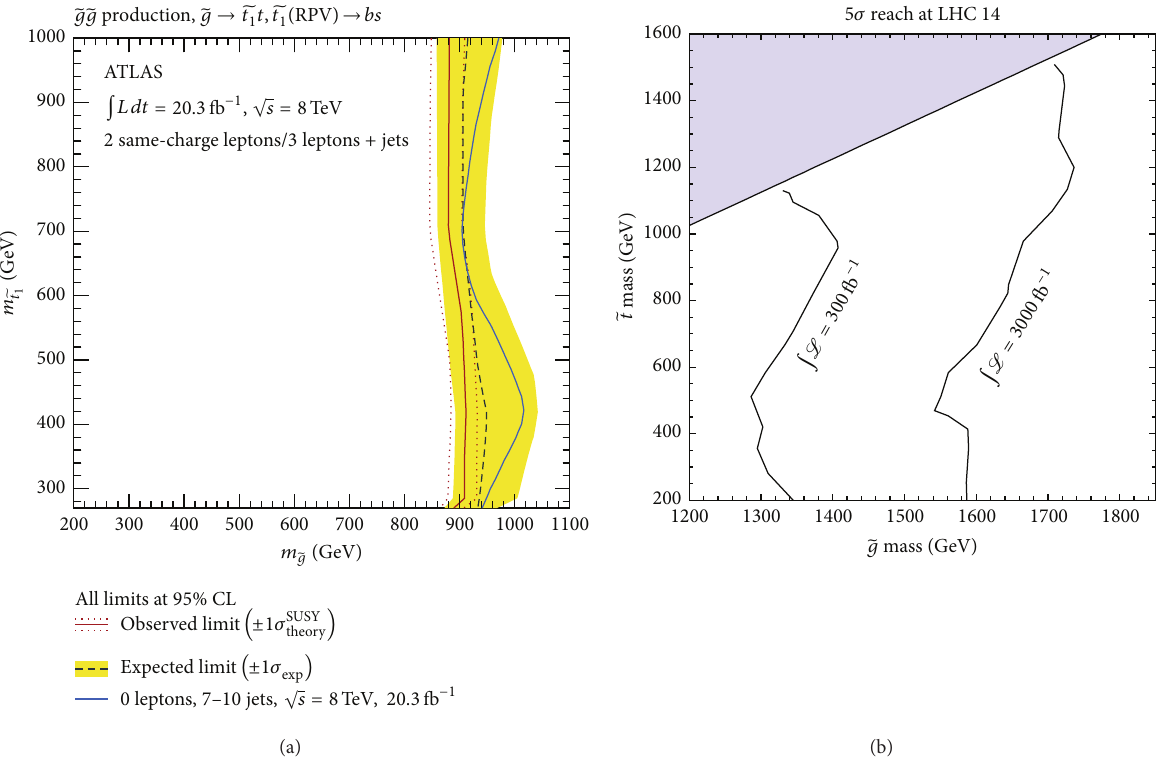
Figure 6: Exclusion from the LHC 8 TeV run (a) [12] and expected discovery reach (b) [13] for the RPV gluino simplified model decaying into heavy flavors in the same-sign dilepton channel. Points at the left of the solid lines are excluded under the assumption indicated by the respective labels.